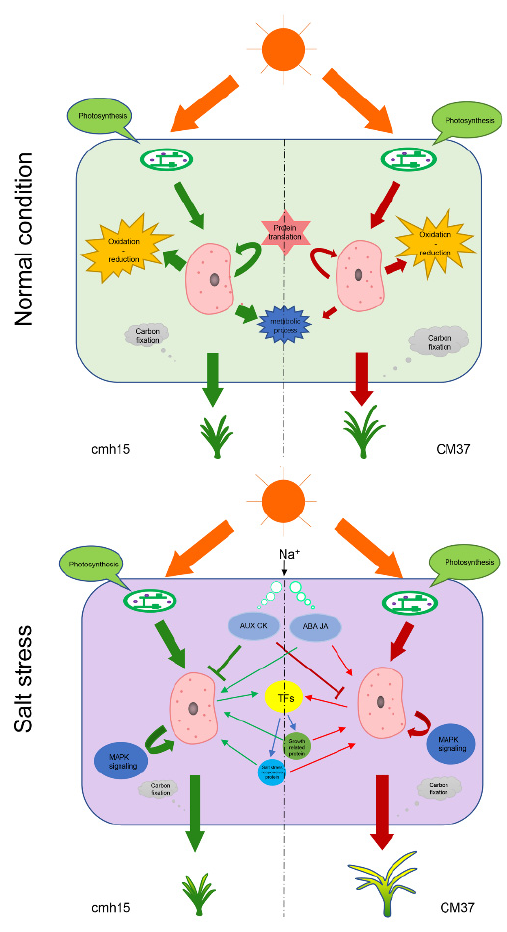
Figure 9. Schematic model illustrating the main processes for obtaining salt tolerance in seedlings of the maize inbred lines CM37 and cmh15. The model is based on the main salt stress responsive DEGs identified in this study.